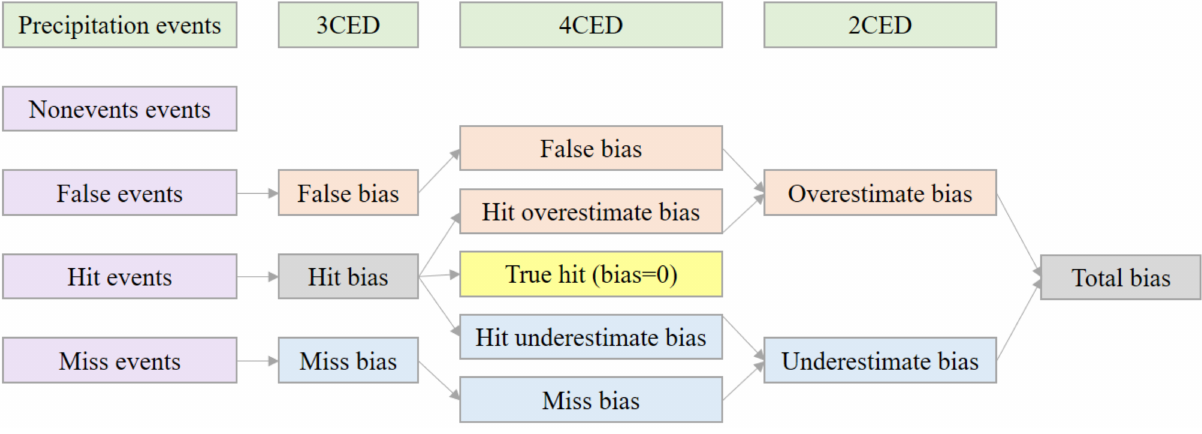
Figure 2. The relationships between 3CED, 4CED, and